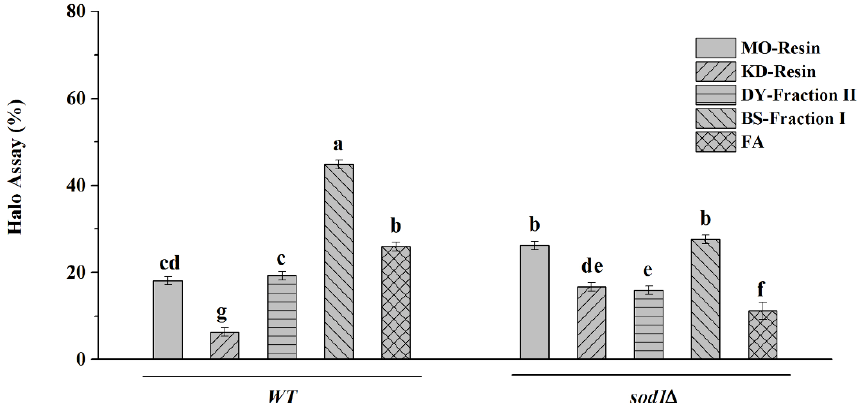
Figure 7. Protective effect of herbal teas and green teas against H 2 O 2 toxicity. The size of the halo was calculated by the cross method and the results were expressed as the cell-protection rate. The capital letters mean statistically different results at p < 0.05.